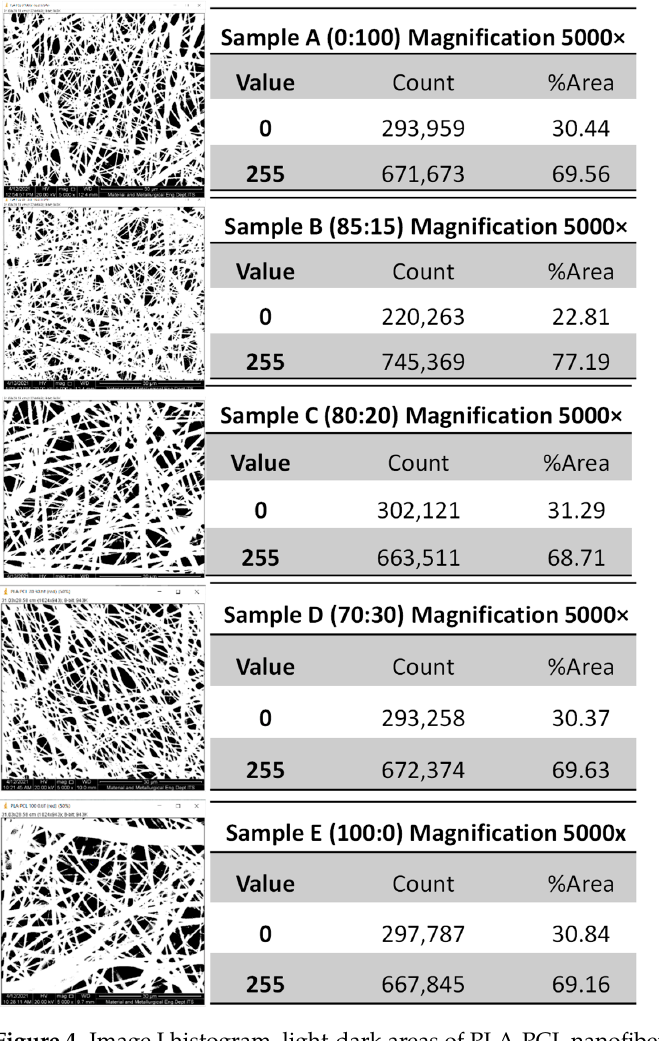
Figure 4. Image J histogram, light-dark areas of PLA-PCL nanofiber scaffolds of the samples with a